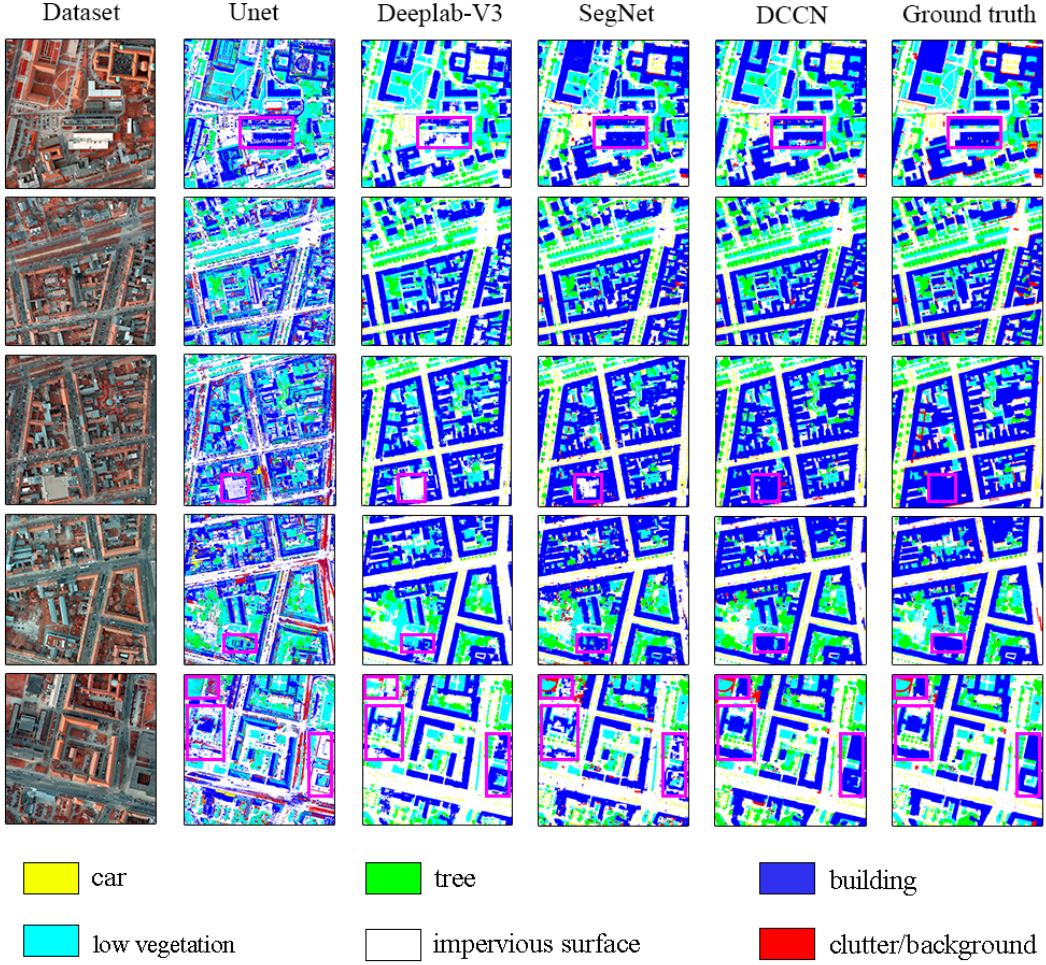
Figure 6. The prediction results of U-net, Deeplab-v3, SegNet and the proposed dense-coordconv network (DCCN) on the validation images. Table 3. Comparisons between the proposed DCCN and several typical models.